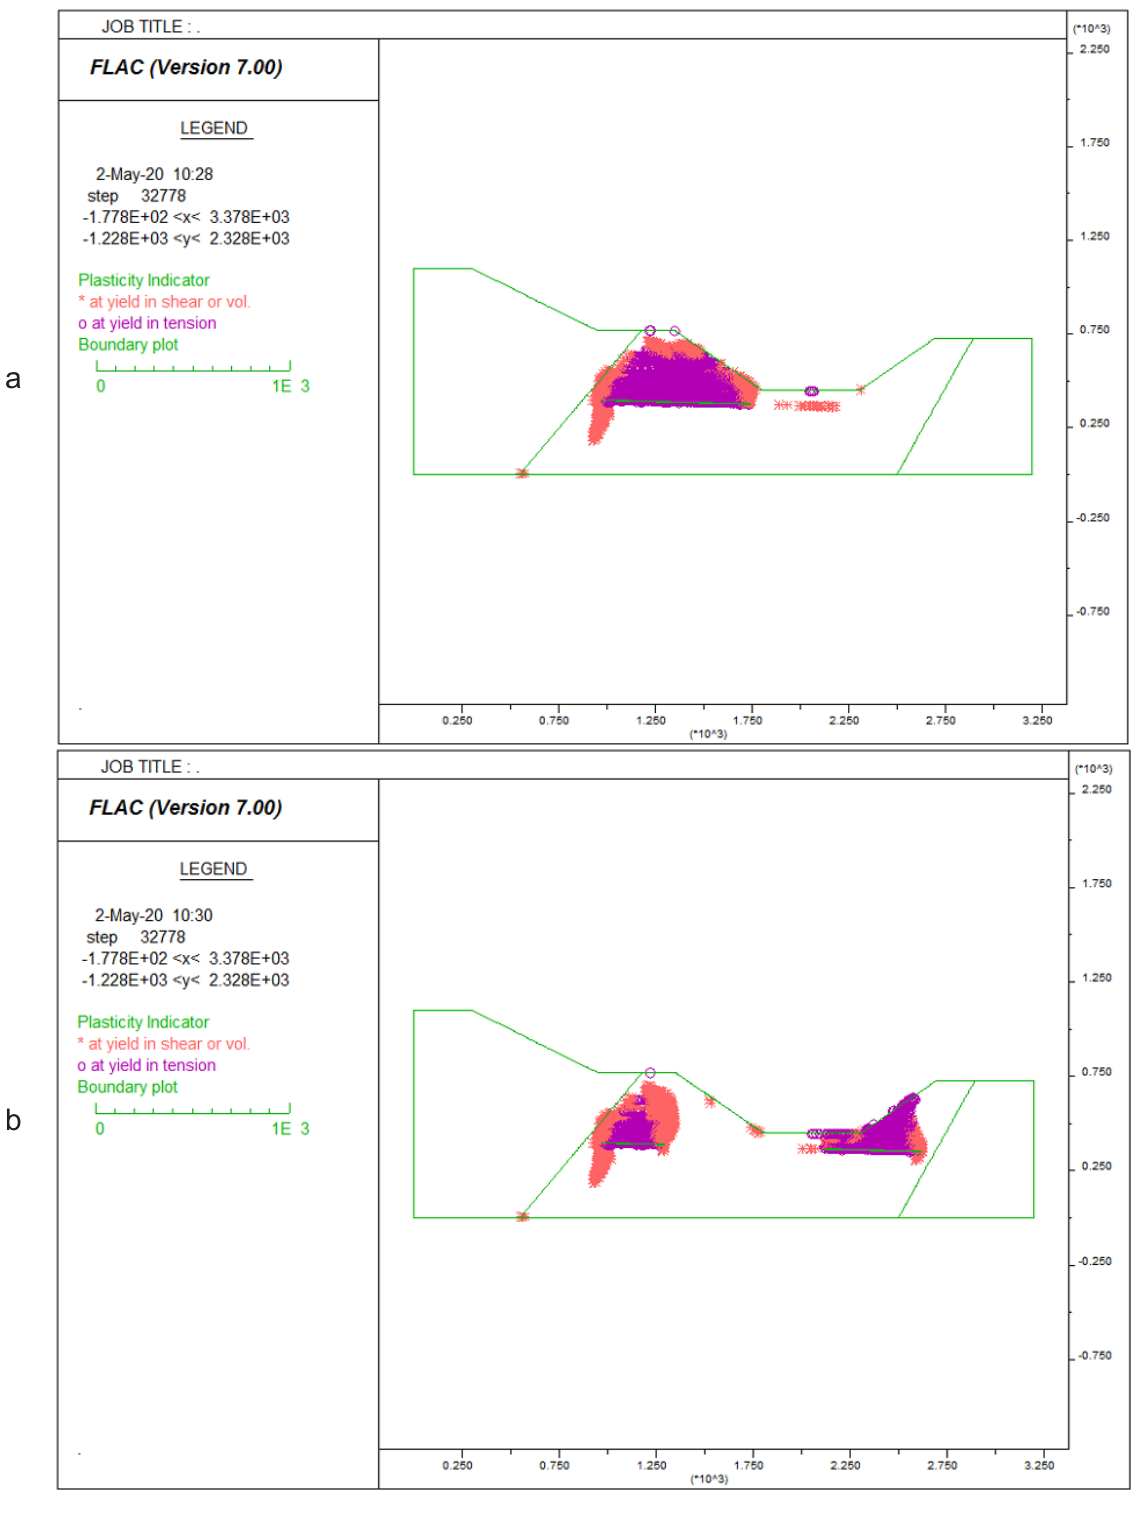
Figure 10: Failure zone induced by UG operation by 2030: (a) scenario IV, (b) scenario